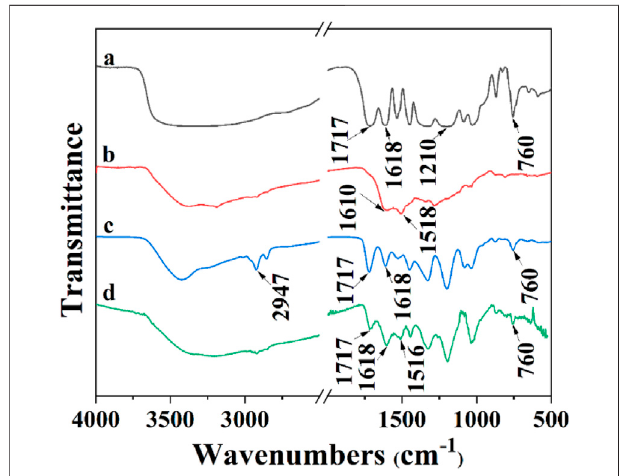
FIGURE 6 | FTIR of TA (A) , PDA (B) , TA-ALL@CS (C) , and PDA/TA- ALL@CS coatings (D)